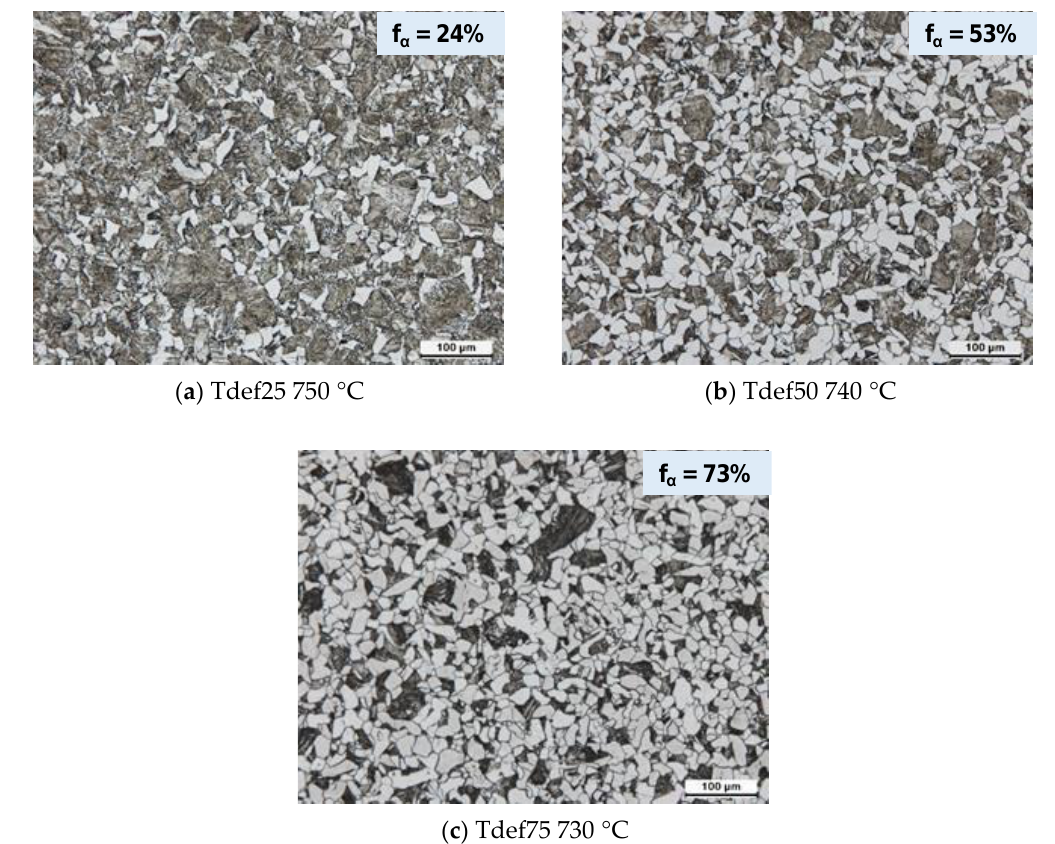
Figure 3. Optical micrographs obtained after a quenching at different deformation temperatures and CMn steel (before intercritical deformation): ( a ) Tdef25, ( b ) Tdef50, and ( c ) Tdef75.